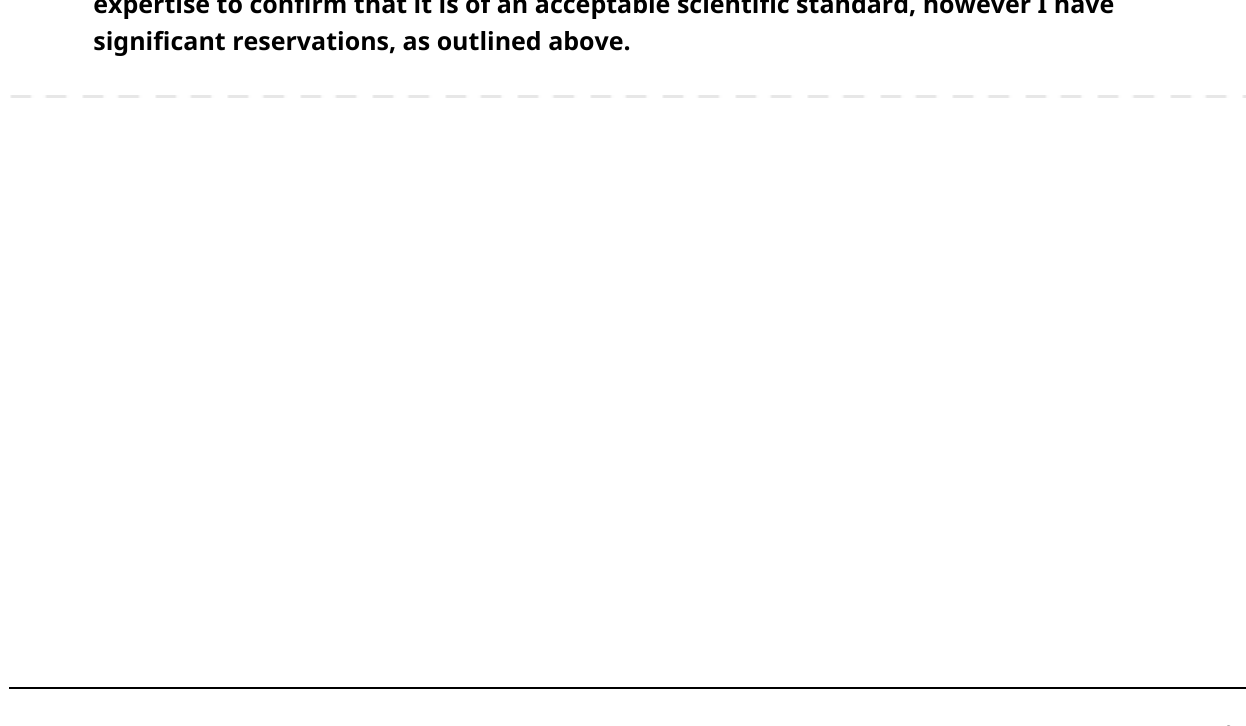
Figure 3D could omit line for CLAK-Eig and CLAK-Chol is unlabeled. ○ The abbreviation in Table S3 cer-cer lpc, pls spm pc pe etc. makes no sense to me. They are different trait classes but still the table adds very